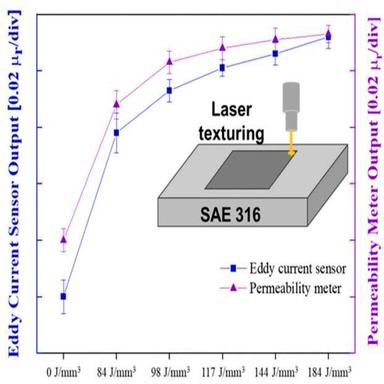
Permeability of laser machined specimen measured by the fiber optic current sensor and the magnet permeability meter.